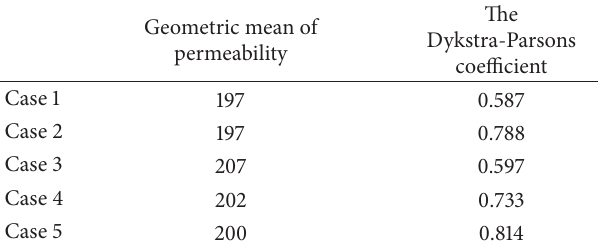
Table 5: Arithmetic means of geometric permeability means and the Dykstra-Parsons coefficients for each